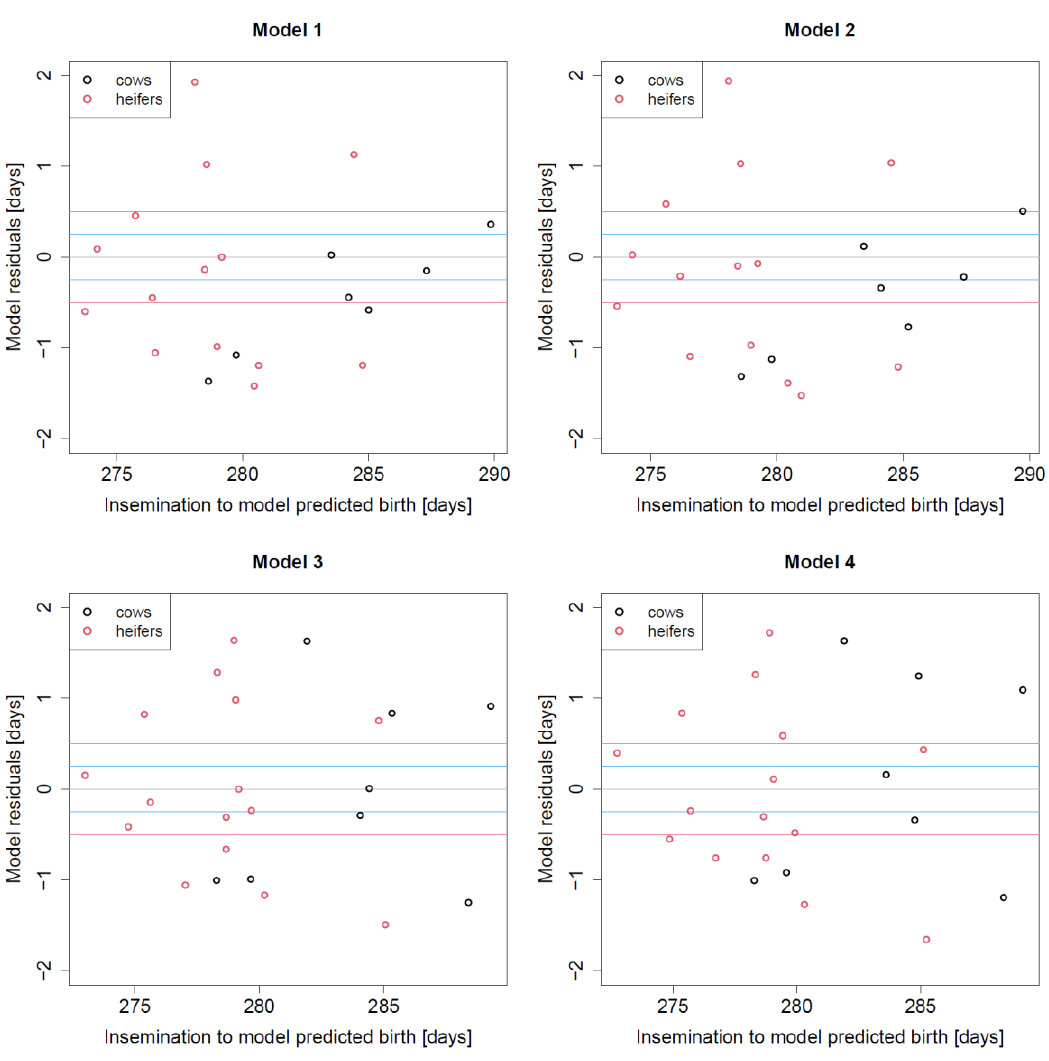
Figure 4. Residual plots for models 1–4, showing model residuals versus predicted birth date. Blue lines indicate deviations +/− 6 h, red lines indicate deviations +/− 12 h.